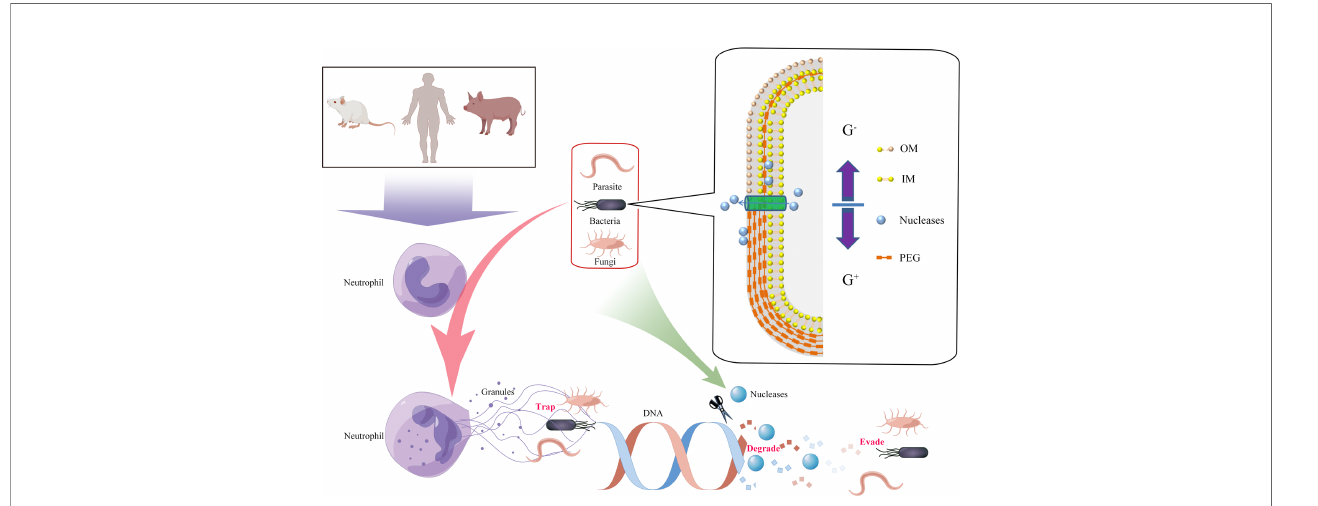
FIGURE 1 | Degradation of extracellular traps (ETs) by the production of pathogen-derived nucleases. Innate immune cells were activated by pathogens, and DNA from nuclei or mitochondria mixed with histones, granular, and cytoplasmic proteins was released to the cellular environment (termed ETs). ETs could immobilize and/or kill the pathogens. However, secreted or cell wallanchored extracellular nucleases of pathogens were capable of destroying DNA backbones of ETs and contributing to evasion of the immune response and development of persistent infections. G + , Gram-positive bacteria; G - , Gram-negative bacteria; OM, outer membrane; IM, inner membrane; PEG,